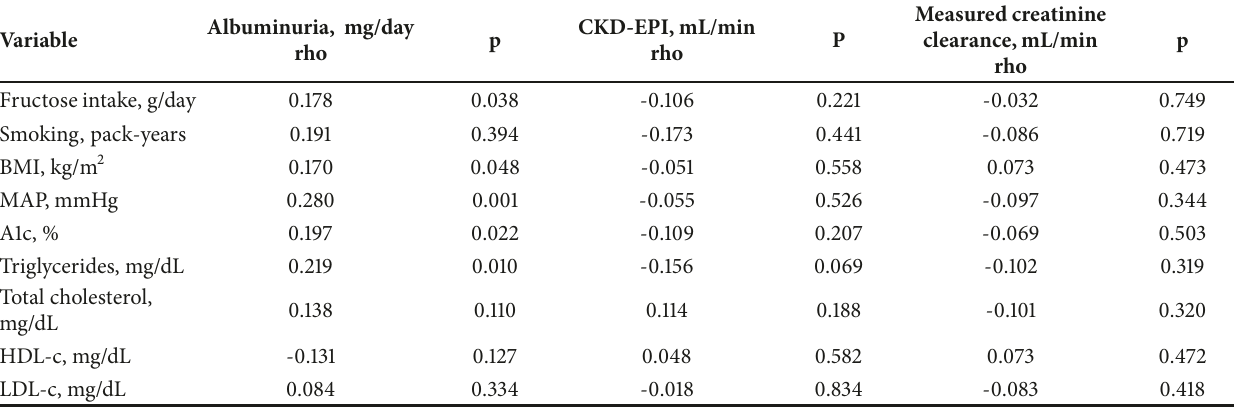
Table 3: Correlation analyses between albuminuria and creatinine clearance with clinical and metabolic variables (n= 136).